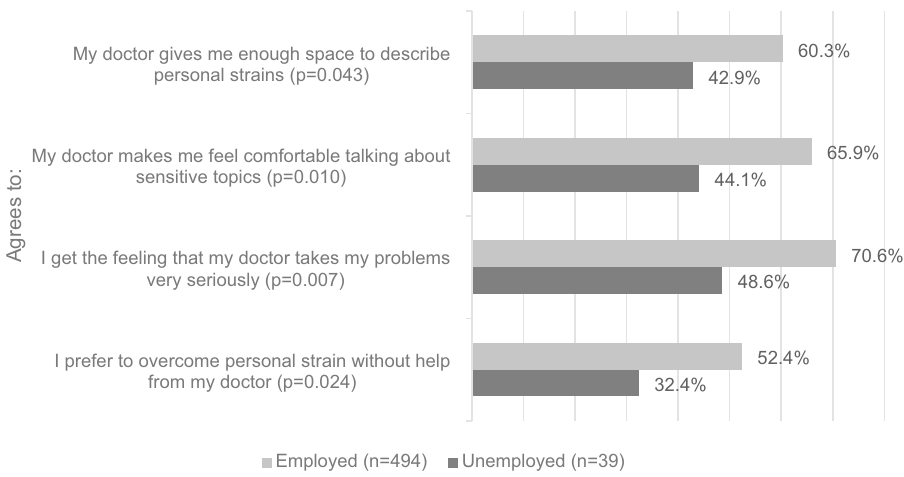
Figure 2. GPCare-1 study: patients’ communication experiences (n = 587) stratified by current employment